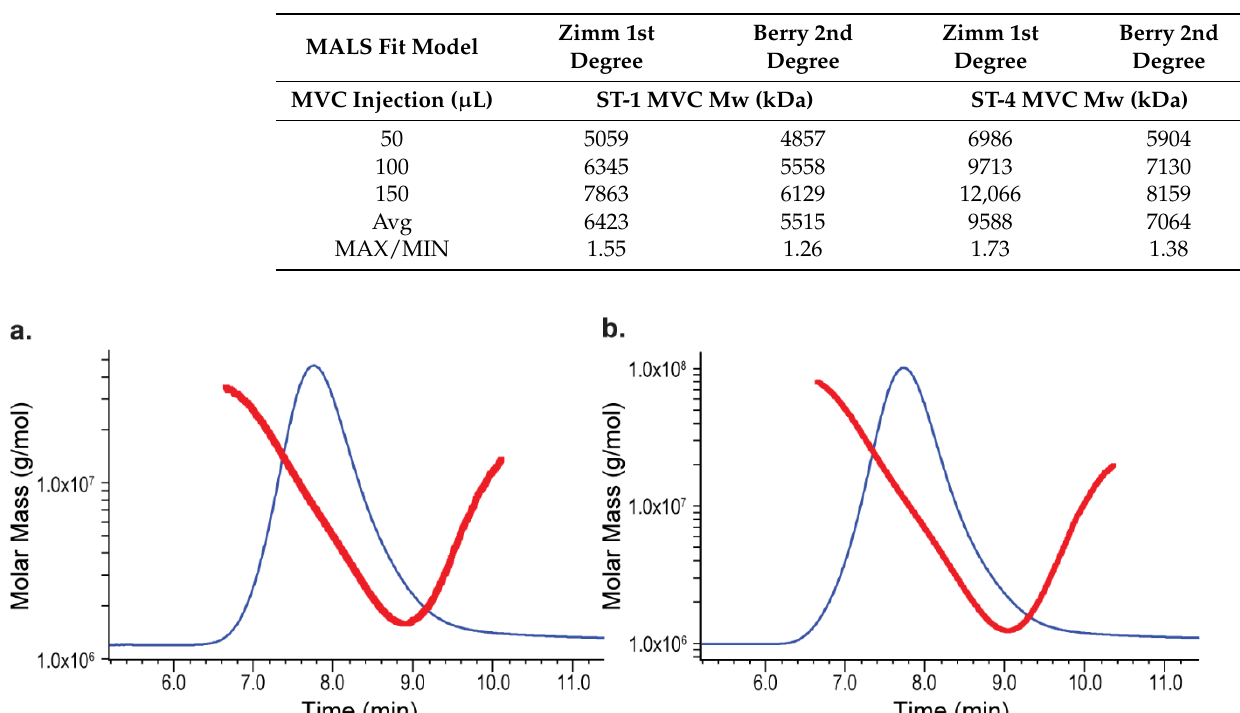
Figure 5. MVC Mw distribution on SEC-MALS: ( a ) ST-1 MVC; ( b ) ST-4 MVC. Each conjugate eluted out as a peak in blue trace. Conjugate molar mass distributions are shown as hook-shaped red lines. Table 3. MVC Mw comparison between Zimm and Berry fit models on SEC-MALS.